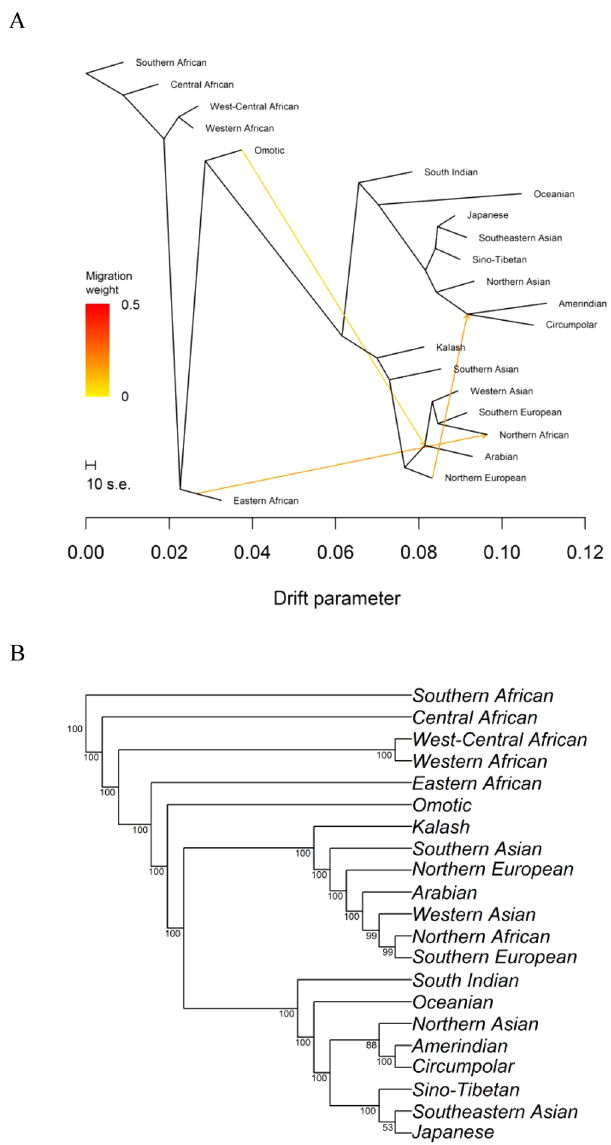
Figure 2. ( A ) The migration graph. TreeMix analysis suggests that migration events occurred between (1) Eastern African and Northern African ancestries; (2) Omotic ancestry and the node leading to Arabian, Northern African, Southern European, and Western Asian ancestries; and (3) Northern European ancestry and the node leading to Amerindian and Circumpolar ancestries. ( B ) Majority-rule consensus tree. The migration events were suppressed to emphasize the underlying